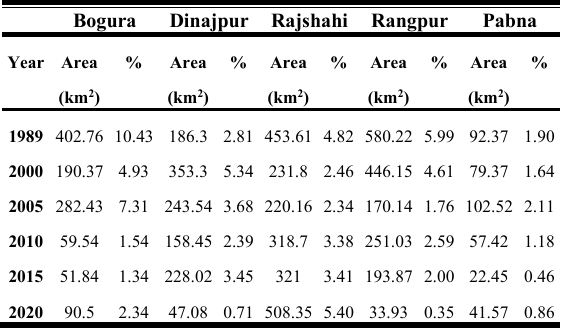
Table 5 . Districts wise wetland distribution in NW BD